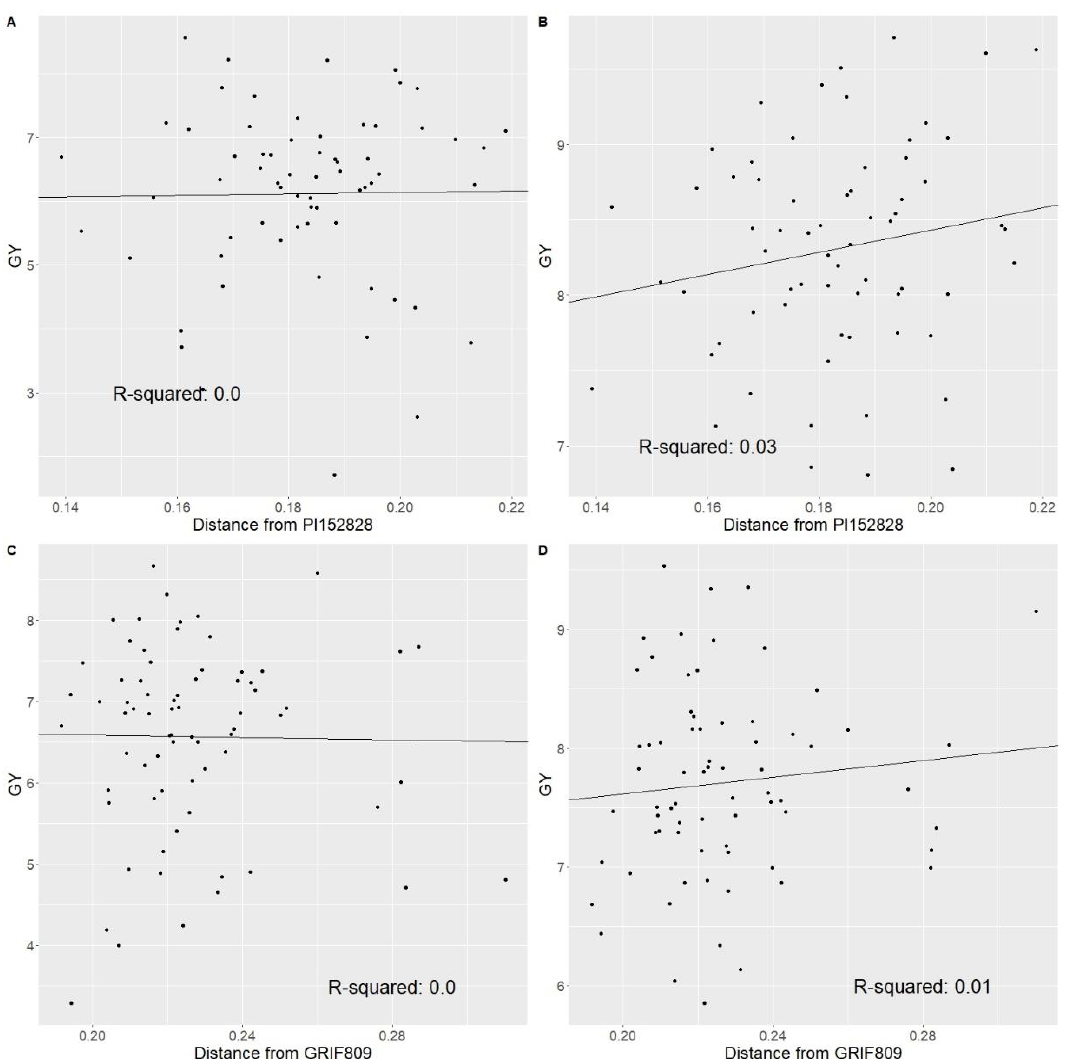
Figure 3. Scatterplots for determining the relationship between genetic distance to introgression parent and grain yield. ( A ) Grain yield in tons/ha (GY) BLUEs in Bushland plotted against genetic distance of GUESS 22 from PI152828 with the line of best fit. ( B ) GY BLUEs in College Station plotted against genetic distance of GUESS 22 from PI152828 with the line of best fit. ( C ) GY blues in Bushland plotted against genetic distance of GUESS 48 from GRIF809 with the calculated line of best fit. ( D ) GY BLUEs in College Station plotted against genetic distance of GUESS 48 from GRIF809 with the calculated line of best fit.